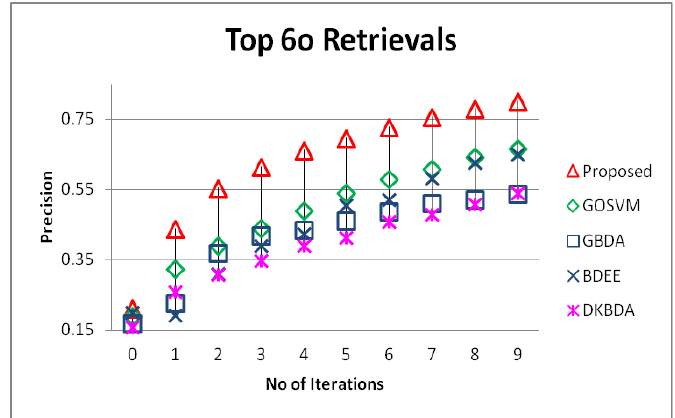
Figure 12. Comparison of the proposed method in terms of precision on top 60 retrievals against GOSVM, GBDA, BDEE and direct kernel biased discriminant analysis